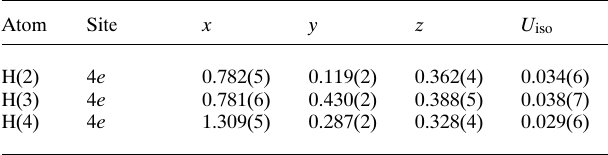
Table 2. Atomic coordinates and displacement parameters (in Å 2 )